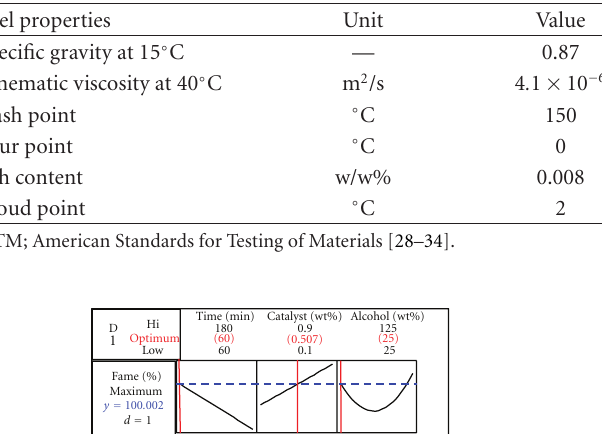
Table 4: Comparison of the fuel properties of the biodiesel resulted from the optimal condition, with ASTM D 6751 standard.